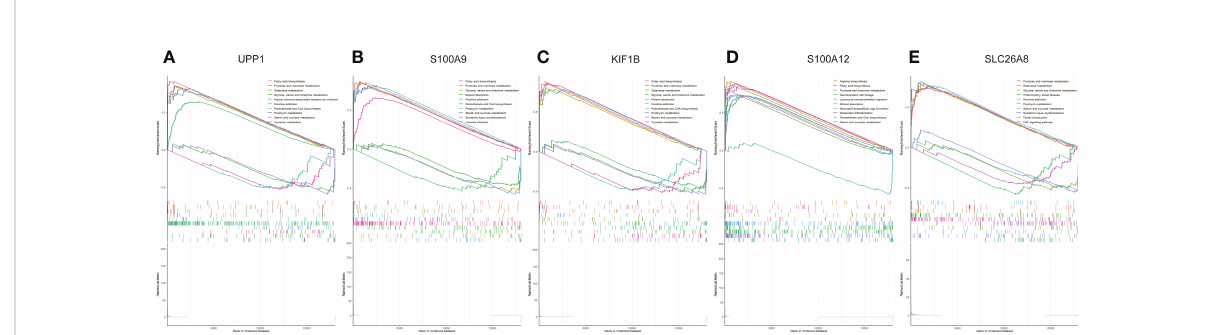
FIGURE 8 The GSEA of the signature genes in pediatric. (A) The GSEA of UPP1 in pediatric septic shock. (B) The GSEA of S100A9 in pediatric septic shock. (C) The GSEA of KIF1B in pediatric septic shock. (D) The GSEA of S100A12 in pediatric septic shock. (E) The GSEA of SLC26A8 in pediatric septic shock.